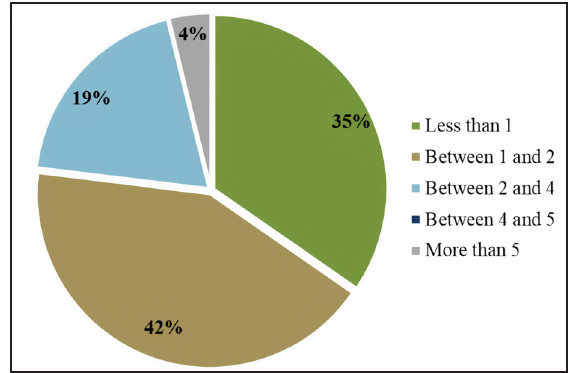
TABLE 6. SWOT Matrix Quadrant 1: Strengths.